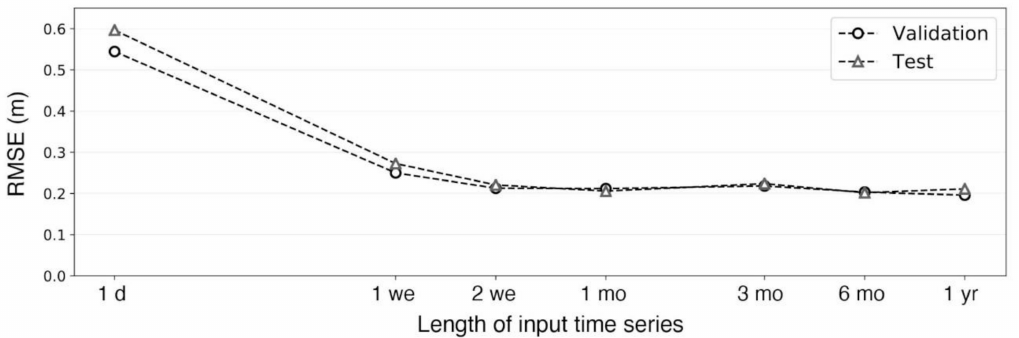
Figure 10. RMSEs for various lengths of the precipitation time series. A given length corresponds to an MLP model constructed with that length. Open circles are for the validation dataset, open triangles for the test dataset.